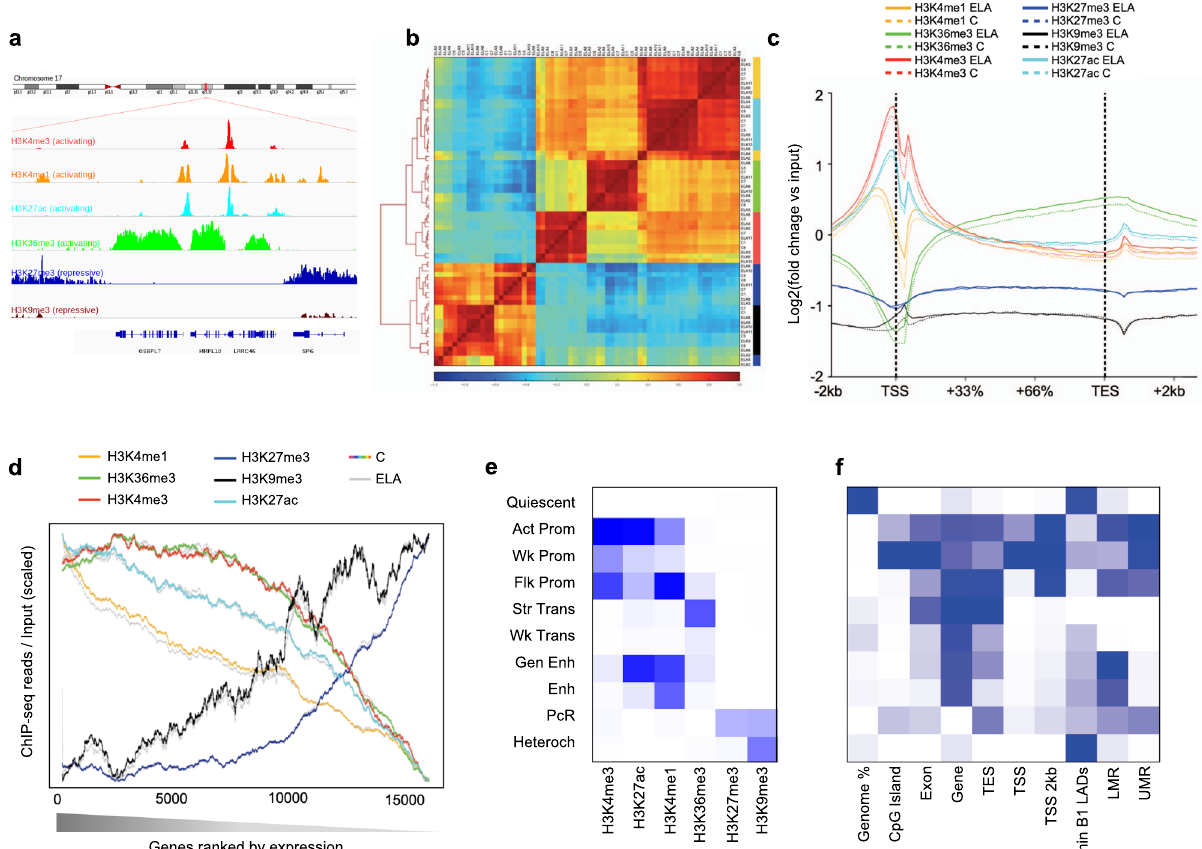
Fig. 1 Characterization of six histone post-translational modi fi cations in the human brain lateral amygdala. a Snapshot of typical ChIP-seq read distribution for the six histone marks. b Unsupervised hierarchical clustering using Pearson correlations for all marks. Correlations were computed using read number per 10 kb-bins across the whole genome and normalized to input and library size. Note the expected separation between activating (H3K27ac, H3K36me3, H3K4me1, H3K4me3) and repressive (H3K27me3, H3K9me3) marks. c Average enrichment over the input of ChIP-seq reads across all